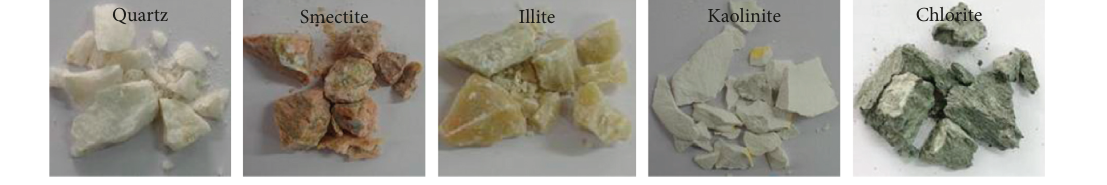
Figure 2: Quartz and clay minerals. Table 2: Basic parameters of LMX formation of Sichuan Basin. X-ray: whole sample, wt.% X-ray: clay mineral relative percentage, wt.%